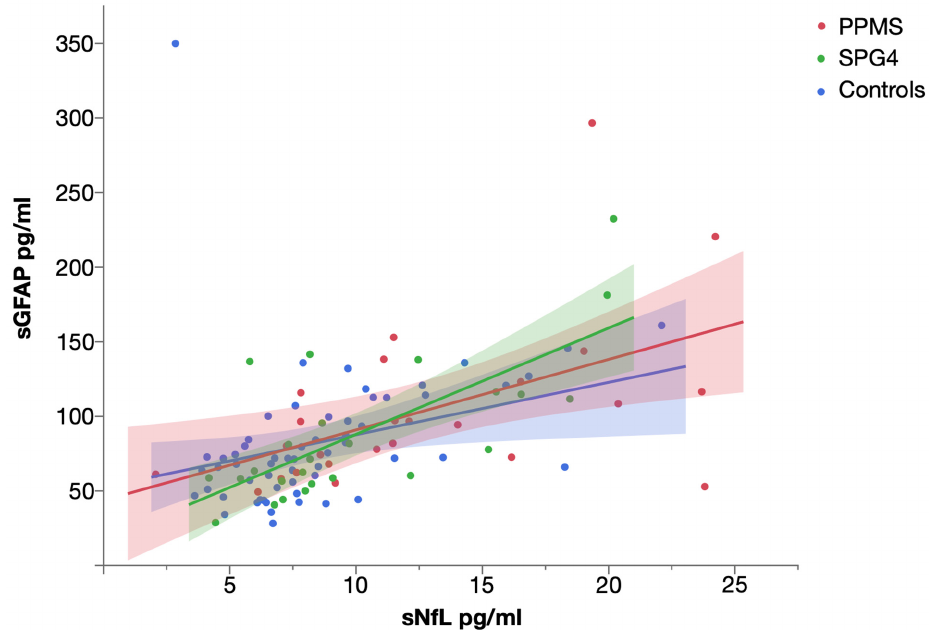
Figure 3. Scatter plot of serum NfL and serum GFAP levels in PPMS, SPG4 and controls, with linear fit. Shaded areas represent 95% confidence intervals. To explore the usefulness of sNfL and sGFAP as diagnostic biomarkers to differenti- ate SPG4 and PPMS, we performed a ROC analysis. Both sNfL (AUC 0.64, 95% CI 0.485– 0.795, p = 0.09) and sGFAP (AUC 0.61, 95% CI 0.452–0.768, p = 0.184) could not reliably distinguish PPMS from SPG4. Combining sNfL and sGFAP by using the product of log values as the test variable did not improve the performance (AUC 0.646, 95% CI 0.493– 0.803, p = 0.076). By contrast, sNfL proved to perform moderately well in differentiating patients with PPMS from controls (AUC = 0.733, 95% CI 0.613–0.852, p = 0.001), and sGFAP showed a low, but significant discriminatory power for these groups (AUC = 0.640, 95% CI 0.515–0.765, p = 0.043). Patients with SPG4 could not be distinguished from controls by sNfL (AUC 0.589, 95% CI 0.456–0.723, p = 0.196) or sGFAP (AUC 0.519, 95% CI 0.377–0.660, p = 0.787). Levels of sNfL significantly increased with age in all three groups (Figure 4). The strongest influence was found in SPG4 (Spearman’s ρ = 0.872, p < 0.001), followed by con- trols (Spearman’s ρ = 0.585, p < 0.001) and patients with PPMS (Spearman’s ρ = 0.439, p = 0.028).